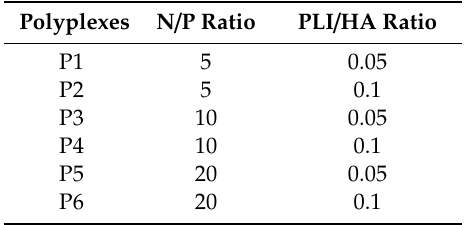
Table 1. MiRNA-34a / PLI / HA ternary polyplexes prepared with various N / P and PLI / HA ratios, in 10mM HEPES bu ff er. Each polyplex contained 3 µ g of miRNA-34a.